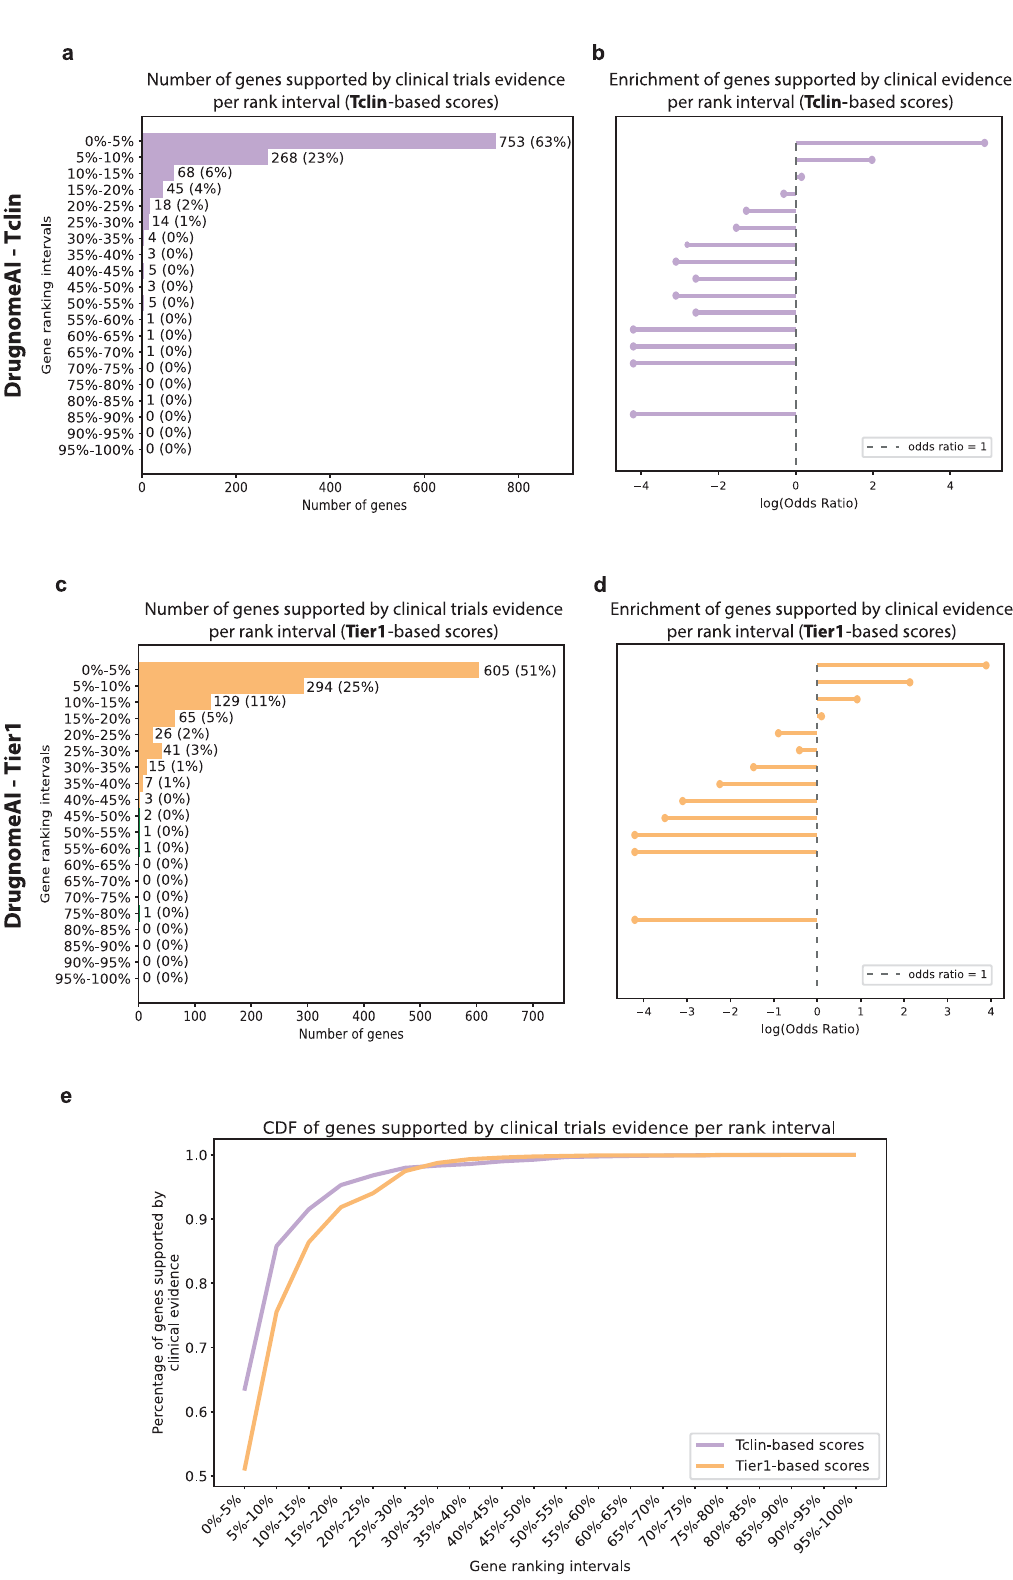
Fig. 3 Validation of DrugnomeAI ranked genes using clinical evidence. Number of genes ( n = 19,846) supported by clinical evidence per rank intervals based on predictions of ( a ) DrugnomeAI-Tclin and ( c ) DrugnomeAI-Tier1. 0 – 5% consists of genes ranked in the top 5% whereas 95 – 100% contains genes ranked in the bottom 5%. Enrichment of genes supported by clinical evidence in each rank interval based on predictions of ( b ) DrugnomeAI-Tclin and ( d ) DrugnomeAI-Tier1. Larger odds ratio values indicate higher enrichment. e Cumulative distribution function (CDF) plot of genes supported by clinical evidence per rank